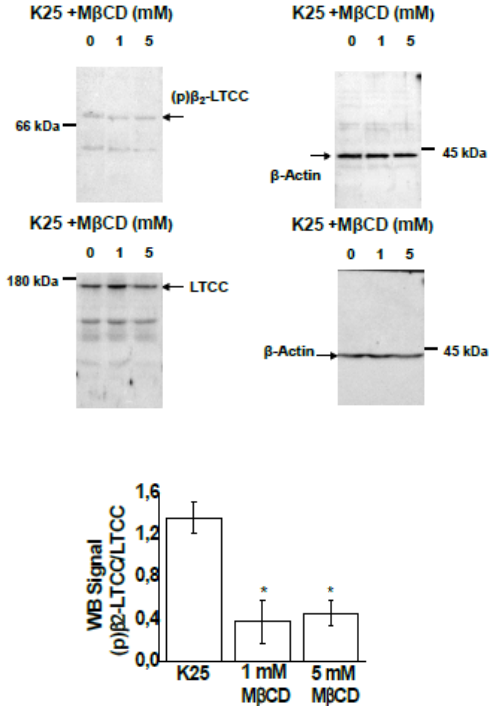
Figure 1. M β CD decreases the phosphorylation level of the β 2 subunit of L-type calcium channels (LTCCs). The phosphorylation level of the β 2 subunit of LTCCs was measured by Western blotting, as indicated below, after the incubation of CGNs in MLocke’s K25 plus 1 or 5 mM of M β CD for 15 min at 37 ◦ C in a 5% CO 2 culture chamber. After SDS-PAGE (7.5% acrylamide), the proteins were transferred to PVDF membranes for Western blotting, as indicated in the Materials and Methods. The positions of the molecular weight marker bands closest to the target proteins of the primary antibodies, i.e., β 2 subunit of LTCCs , LTCC α 1C subunit, and β -actin, are shown at the left or right side of the corresponding PVDF membrane images. The phosphorylation levels of the β 2 subunit of LTCCs , (p)β 2 LTCC/LTCC, were measured using the ratio between the intensities of the ~73 and ~174 kDa bands obtained with rabbit antibodies: PCCb2-140AP (FabGennix Inc., Frisco, TX, USA) — dilution 1:100 [(p)β 2 LTCC] — and anti-LTCC- α 1C -subunit (Santa Cruz Biotechnology, Heidelberg, Germany, sc-25686) — dilution 1:100 [LTCC], respectively. For quantification of the ratio (p)β 2 LTCC/LTCC, the intensities of the bands were normalized first to the intensities of their corresponding ~42 kDa anti- β -actin bands (mouse anti- β -actin A1978, 0.75 µg/mL) as the internal control of protein loading. See Materials and Methods for other experimental details. Images shown are representative of the results obtained in experiments done with at least three different CGN preparations. The average results ± S.E. of triplicate experiments are presented as a bar plot. (*) p < 0.05. 2.2. PKA and CaMK-II Are Associated with Caveolin-1-Rich Lipid Rafts in the Plasma Membrane of CGNs To evaluate the relative distribution of proteins between lipid raft and non-lipid raft membrane fractions, we experimentally assessed: (1) the presence of PKA and CaMK-II in caveolin-1-rich lipid rafts prepared from of mature CGNs in culture and (2) the percentage of immunoprecipitation of PKA and CaMK-II with caveolin-1 in cell lysates treated with 1% Triton X-100. Lipid rafts were prepared as indicated in the Materials and Methods section from mature CGNs in MLocke ’s K5 (proapoptotic conditions) and also in partially depolarizing plasma membrane media, K25 (survival conditions). Lipid raft fractions were characterized using H-Ras, caveolin-1, and flotillin as protein markers, as in previous works [8 – 10]. Western blots of lipid raft fractions show that PKA and CaMK-II are present in lipid rafts prepared from CGNs in MLocke ’s K5 and K25 (Figure 2A). Note, however, that these protein kinases are not only present in the lipid raft fractions, since PKA and CaMK-II are also present in other membrane fractions.